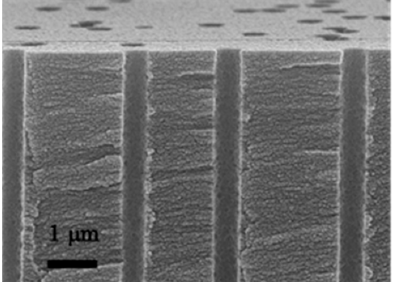
Figure 2. Cross-sectional SEM image of ion-track-etched capillaries created in a heat-treated polyimide film after an etching time of 20 min.